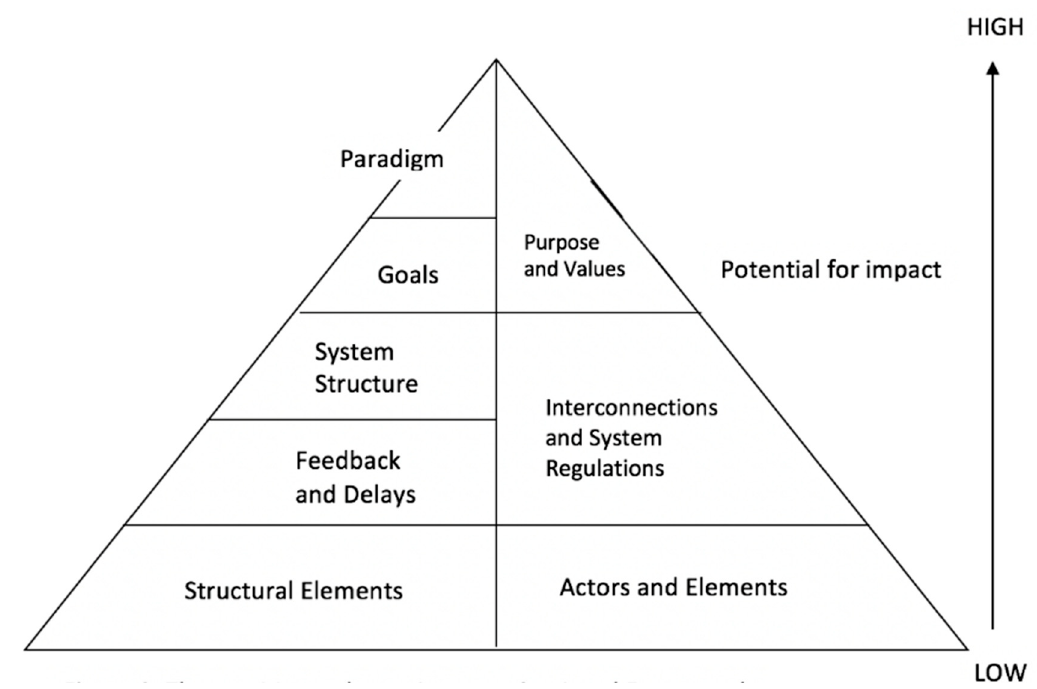
Figure 2. Themes mapped onto the Intervention Level Framework .